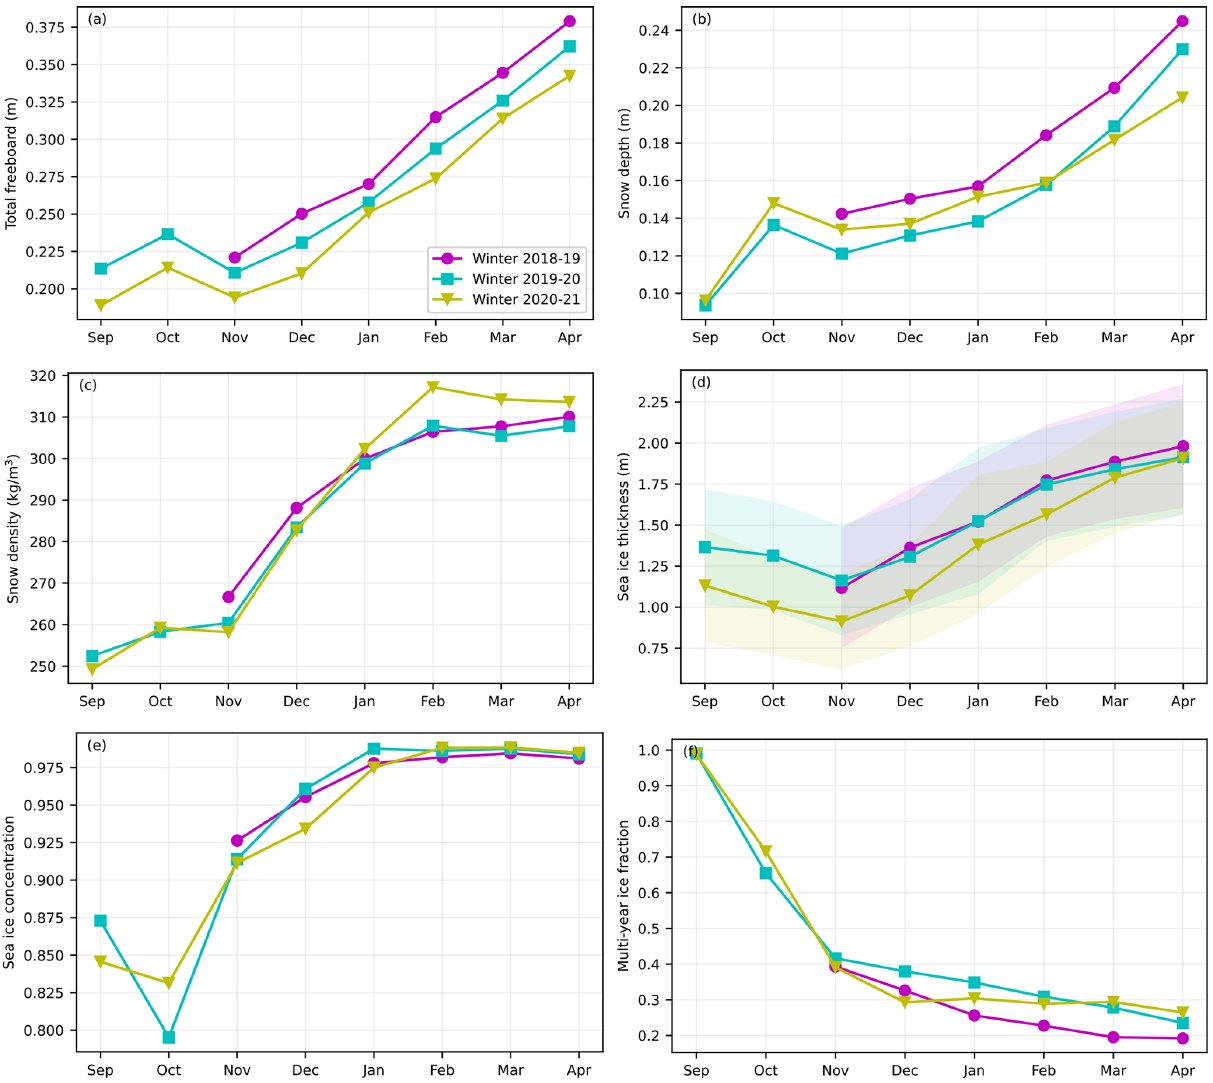
Figure 12. Time series of monthly mean ICESat-2 Inner Arctic Ocean sea ice freeboard (a) , redistributed NESOSIM v1.1 snow depth (b) , NESOSIM v1.1 snow density (c) , OSI SAF multiyear ice fraction (d) , CDR sea ice concentration (e) and resultant sea ice thickness (f) for the 2018/2019, 2019/2020 and 2020/2021 winters. Monthly means are generated using monthly gridded ICESat-2 thickness estimates (IS2SITMOGR4 v2, shown in Fig. 8), within our Inner Arctic Ocean domain (Fig. 5). The shading in panel (d) represents the mean systematic thickness